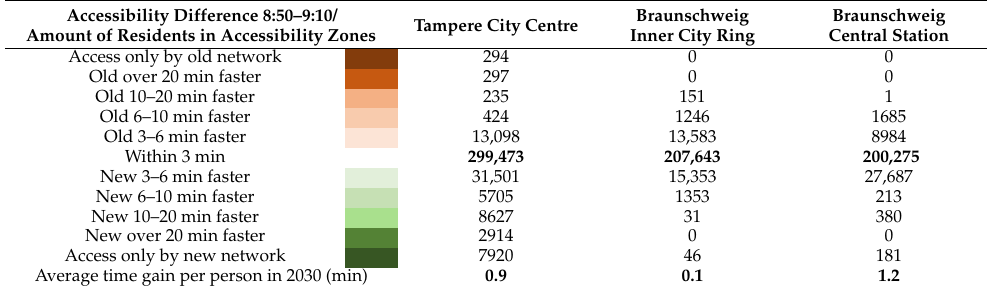
Table 1. The accessibility changes of case areas per how large of a population they affect. Accessibility Difference 8:50–9:10/ Amount of Residents in Accessibility